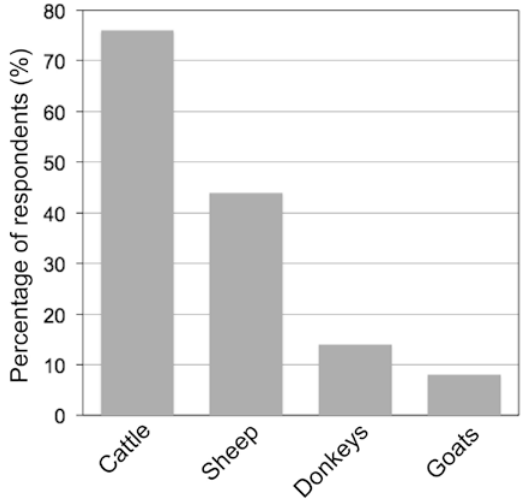
Figure 9. Percentage of respondents utilising forest to graze various livestock as of 2015, identified by the questionnaire survey ( n = 327).